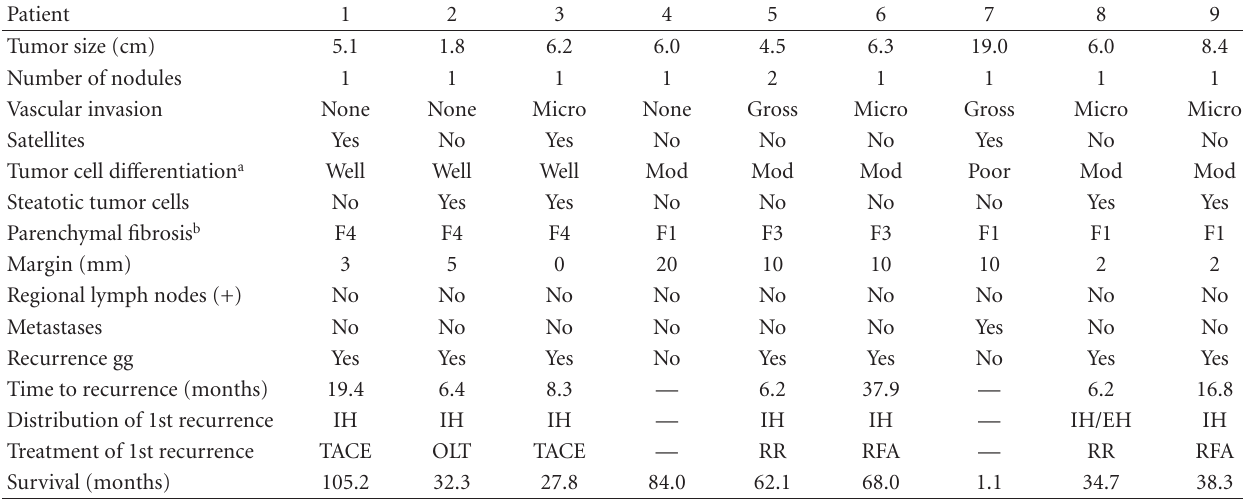
Table 4: Pathological data and longterm